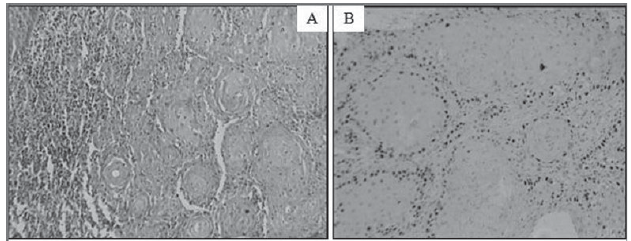
Fig. 5 H/E (A) and IHC staining with p53 expression (B) showing well differentiated squamous cell carcinoma (10x).